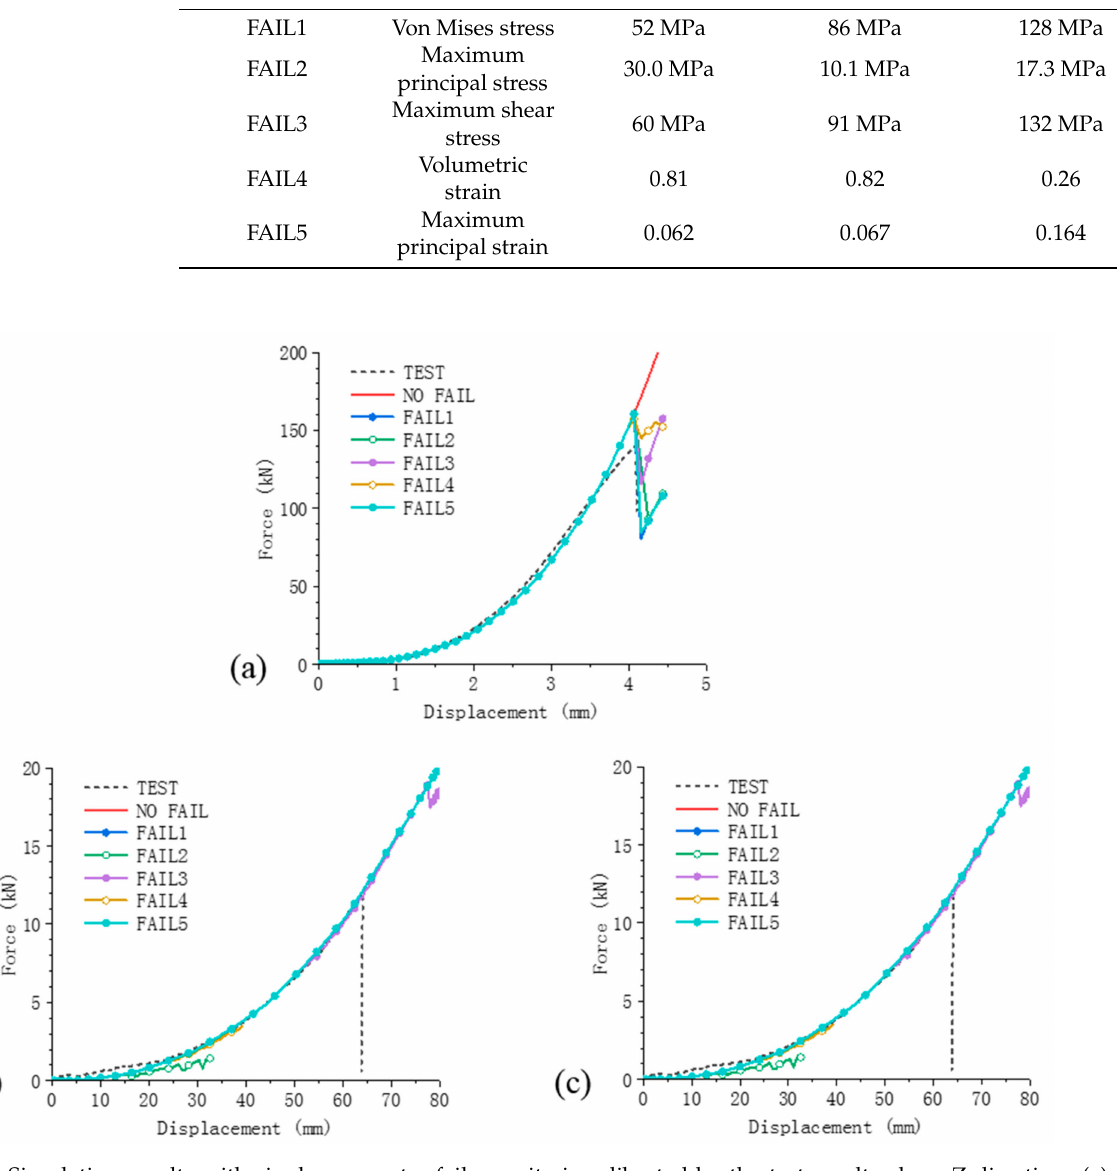
Figure 8. Simulation results with single-parameter failure criteria calibrated by the test results along Z direction: ( a ) Z-direction; ( b ) Y-direction; ( c )